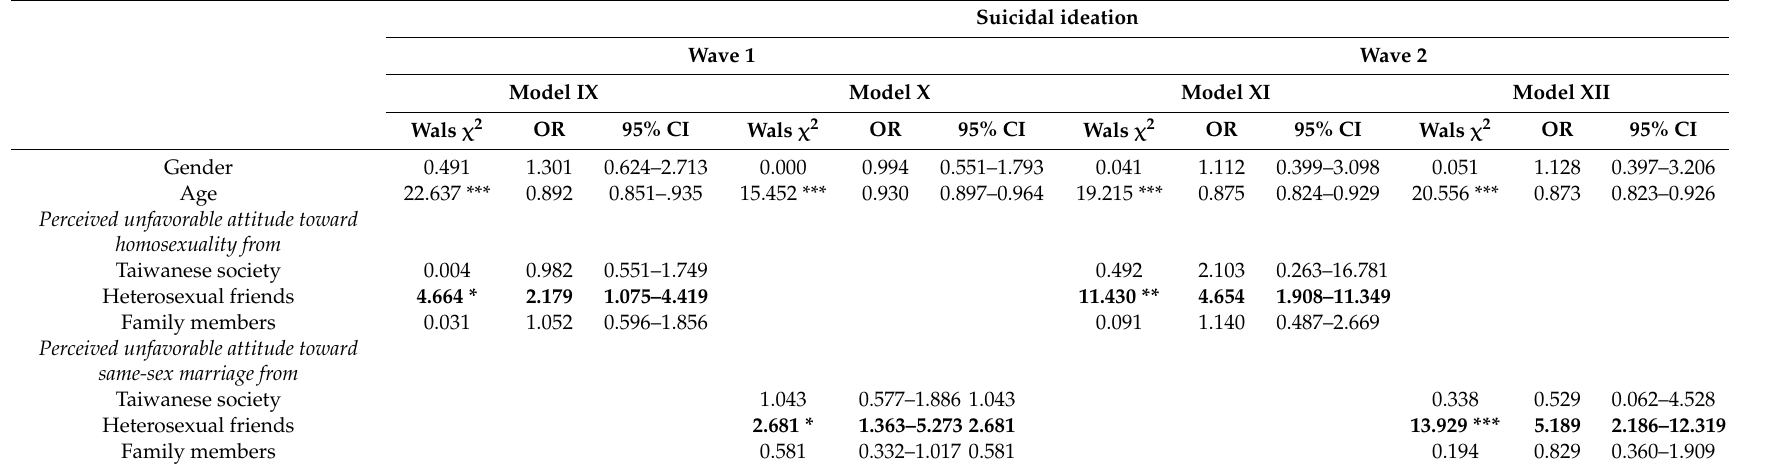
Table 4. Association of perceived unfavorable attitudes toward homosexuality and same-sex marriage from Taiwanese society, heterosexual friends, and family members with suicidal ideation in heterosexual participants with a favorable attitude toward